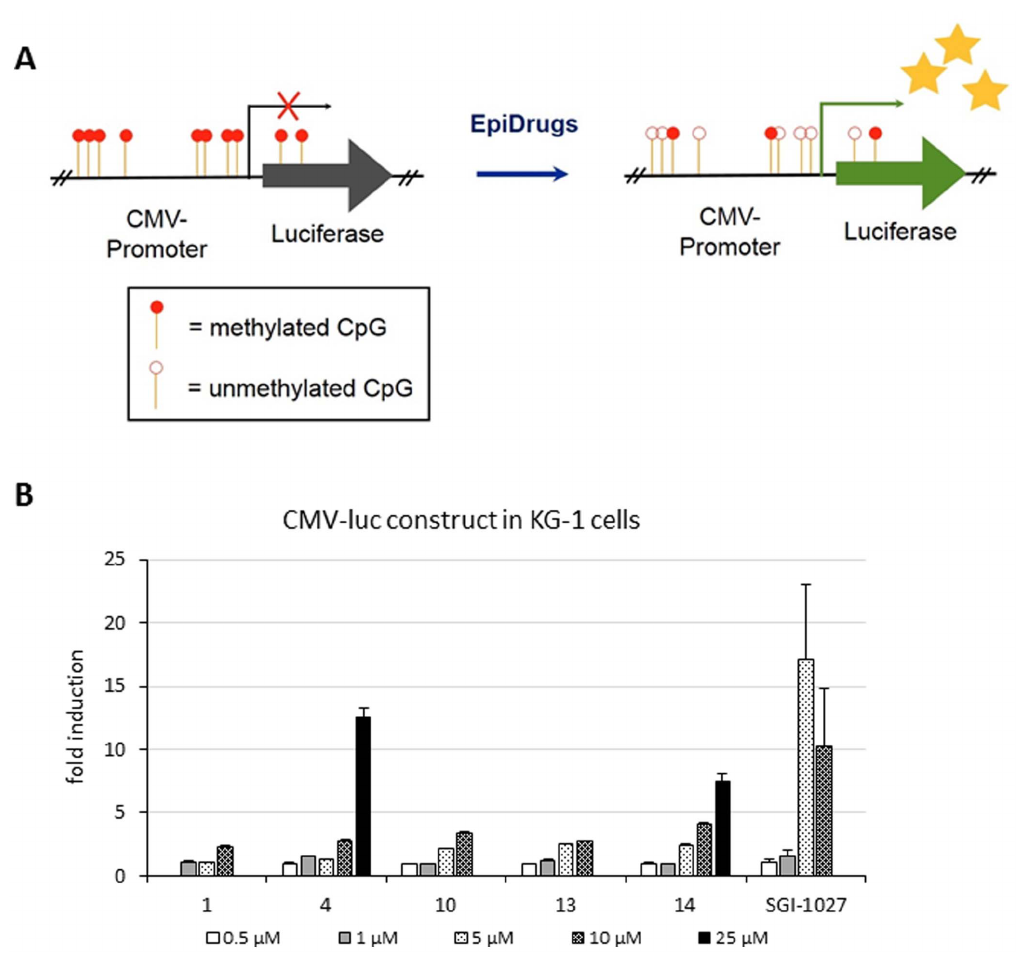
Figure 3. Effect of selected compounds on the induction of the luciferase signal at the CMV-luc construct in KG-1 cells. (A) CMV-luc construct to detect changes in methylation at the CMV promoter in KG-1 cells. (B) Modulation of induction of luciferase expression of CMV-luc after treatment with different doses of 1 , 4 , 10 , 13 and 14 . SGI-1027 was used as a reference drug. Values are means of at least two experiments. Cytotoxicity of DNMT inhibitors in KG-1 cells causes a decrease or loss of luciferase induction.